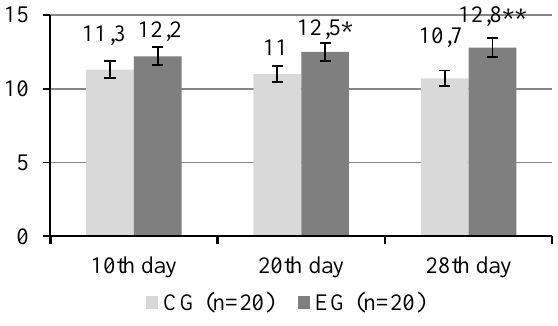
Fig. 4. The leukocyte rate in blood of suckling piglets